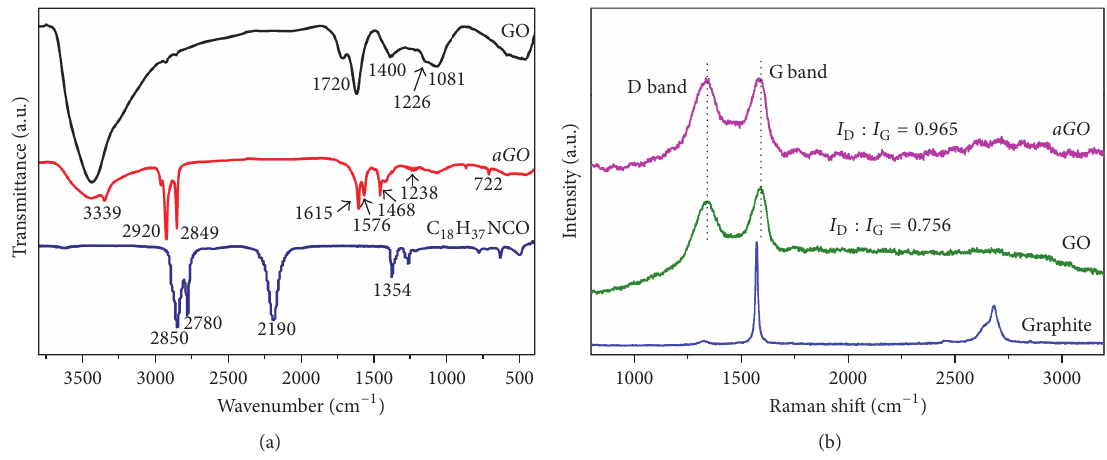
Figure 2: (a) FTIR spectra and (b) Raman spectra of GO, alkylated- grafted -GO (aGO), and CH 3 (CH 2 ) 17 NCO.